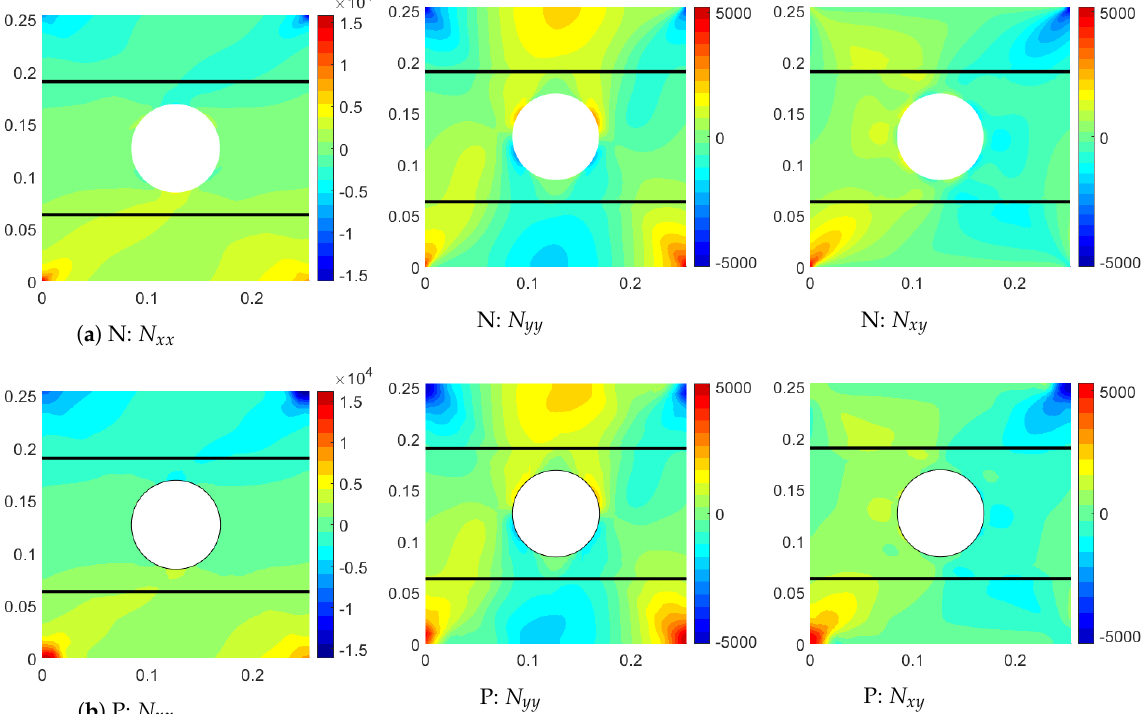
Figure 20. Comparison of stress resultants (unit: N/m) of the stiffened plate under pure in-plane bending displacements. ( a ) N: NASTRAN results; ( b ) P: Present results.